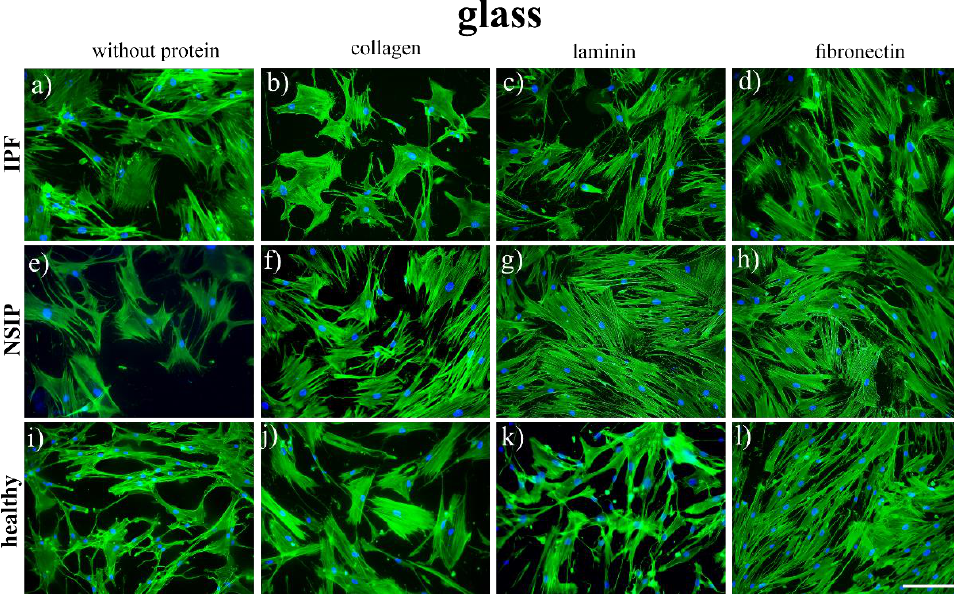
Figure 1. Fluorescence micrographs of the actin cytoskeleton (green) and nuclei (blue), recorded for IPF- and NSIP-derived, as well as healthy fibroblasts cultured on control glass substrates ( a , e , i ) cov- ered with collagen ( b , f , j ), laminin ( c , g , k ), and fibronectin ( d , h , l ). The scale bar corresponds to 100 µ m (objective magnification 20×).